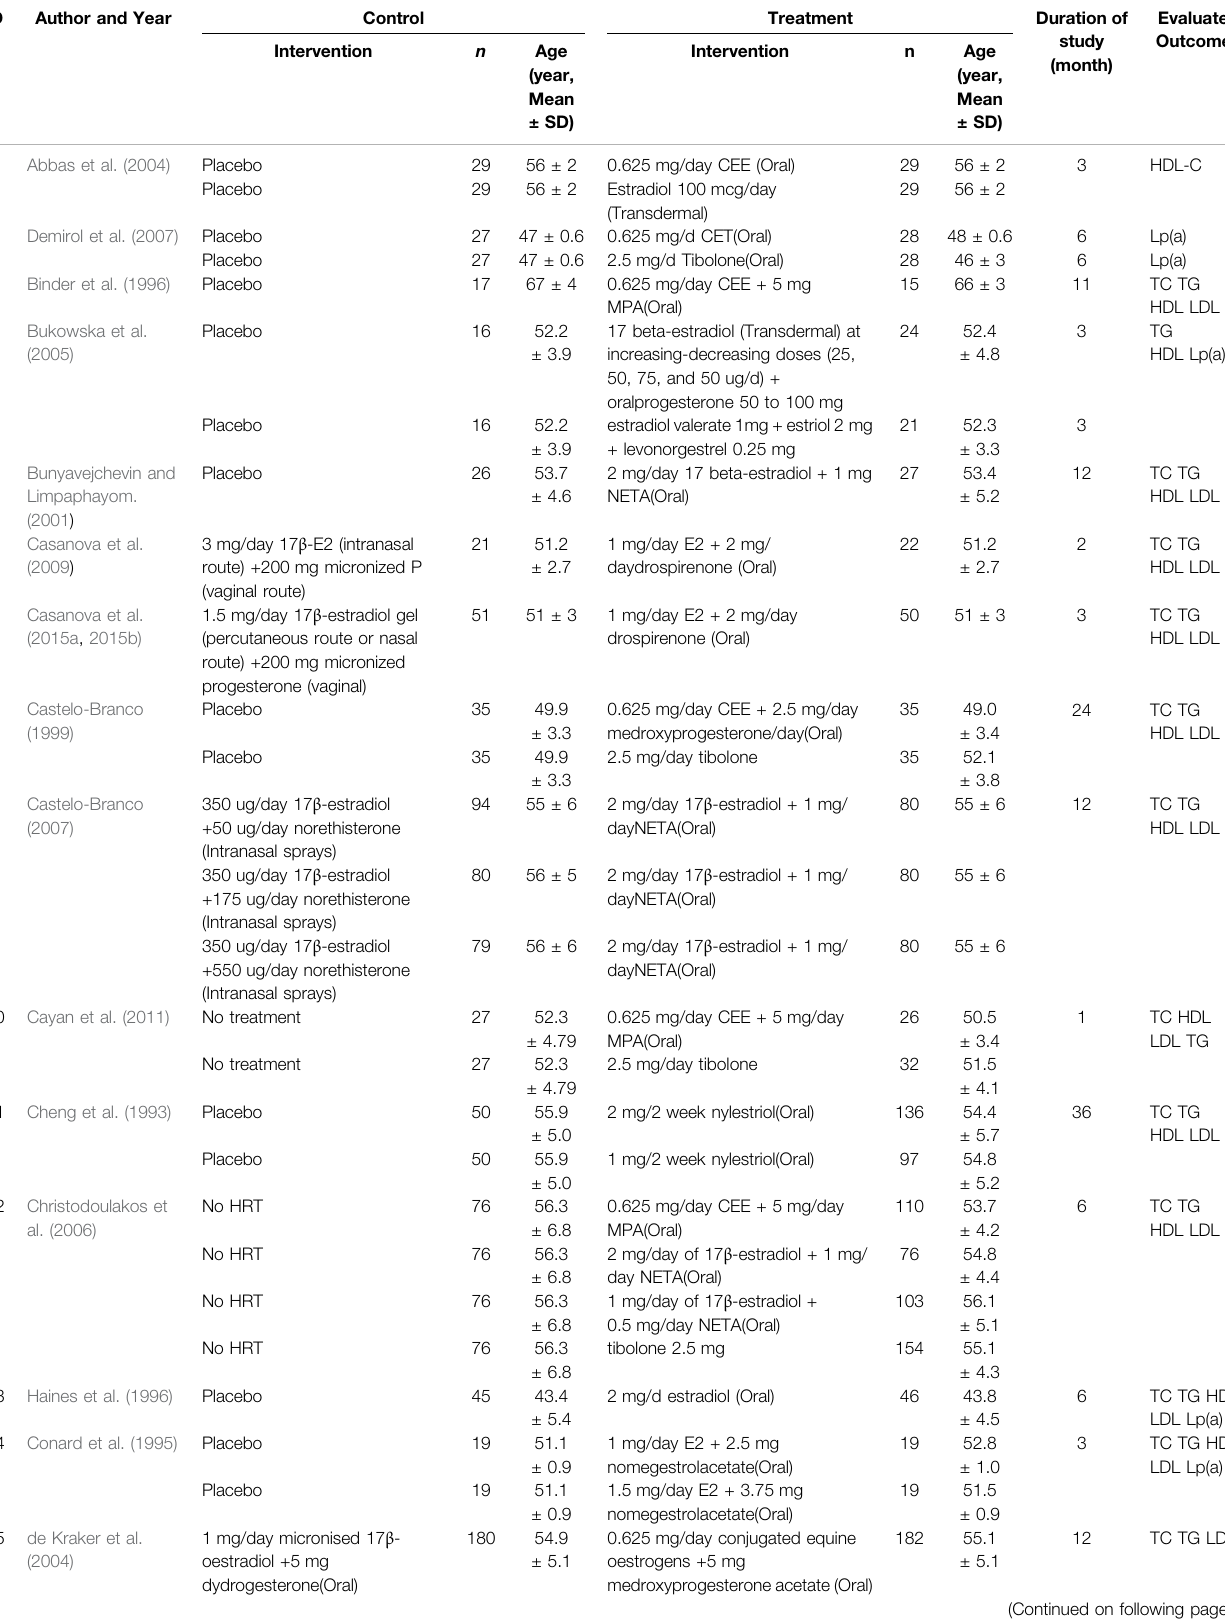
TABLE 1 | Baseline characteristics and clinical outcomes of menopausal women with menopause hormone therapy